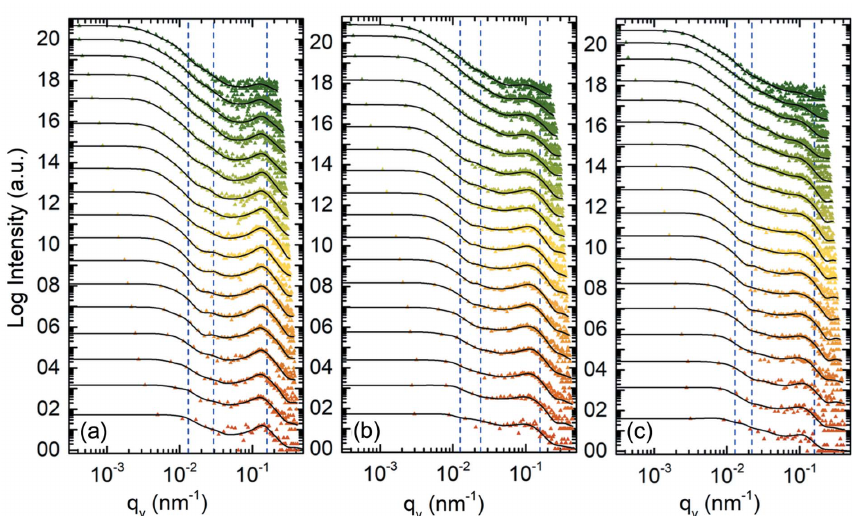
Figure 4 Horizontal line cuts for ( a ) the as-prepared mesoporous titania film, ( b ) PTB7-Th infiltrated titania and ( c ) PhenTe-BPinPh infiltrated titania. Solid lines represent the best model obtained for the data and dashed lines indicate the peak position of modeled structure factors. The curves are shifted along the intensity axis for clarity. Neutron wavelength bands increase from bottom to top (3.3– 18.1 A˚ the modeling results extracted from ToF-GISANS data. The